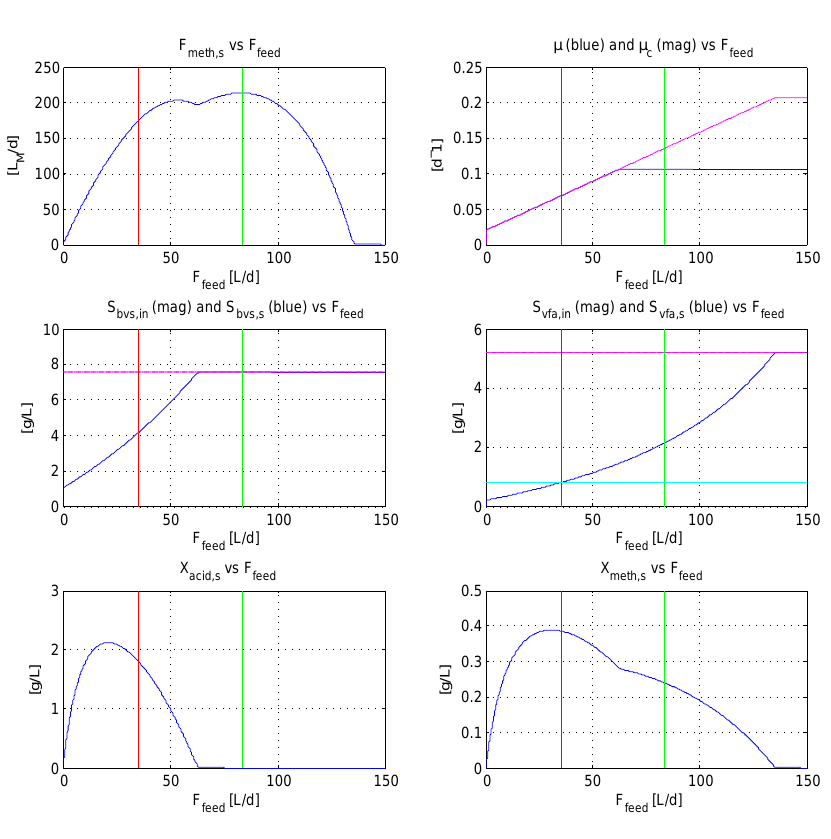
Figure 4: Simulated static (steady-state) values of a number of variables versus F feed (constant) at T reac = 35 o C. Vertical and horizontal lines are explained in the